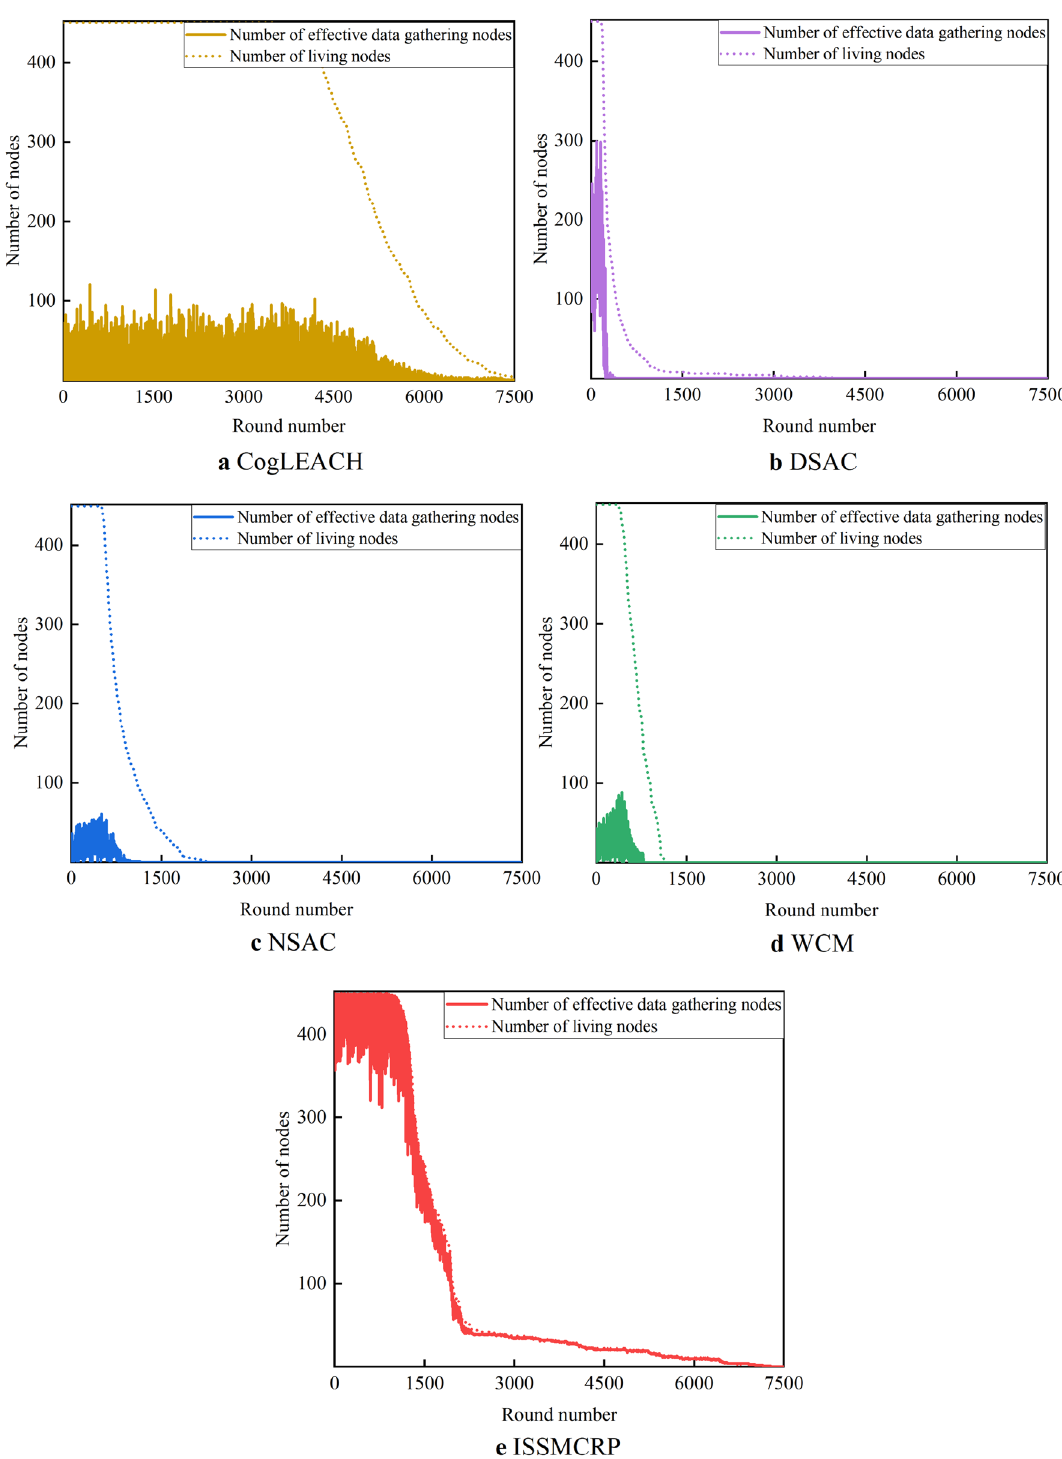
Figure 12. Comparison of number of effective data gathering nodes and number of living